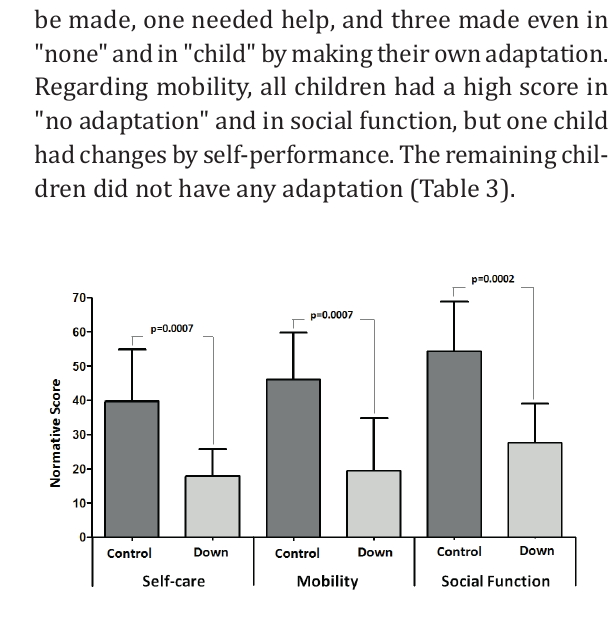
Figure 1 – Comparison between mean and standard deviation of the normative score values of Part I – Functional Capabilities of PEDI between both groups. (n = 20)